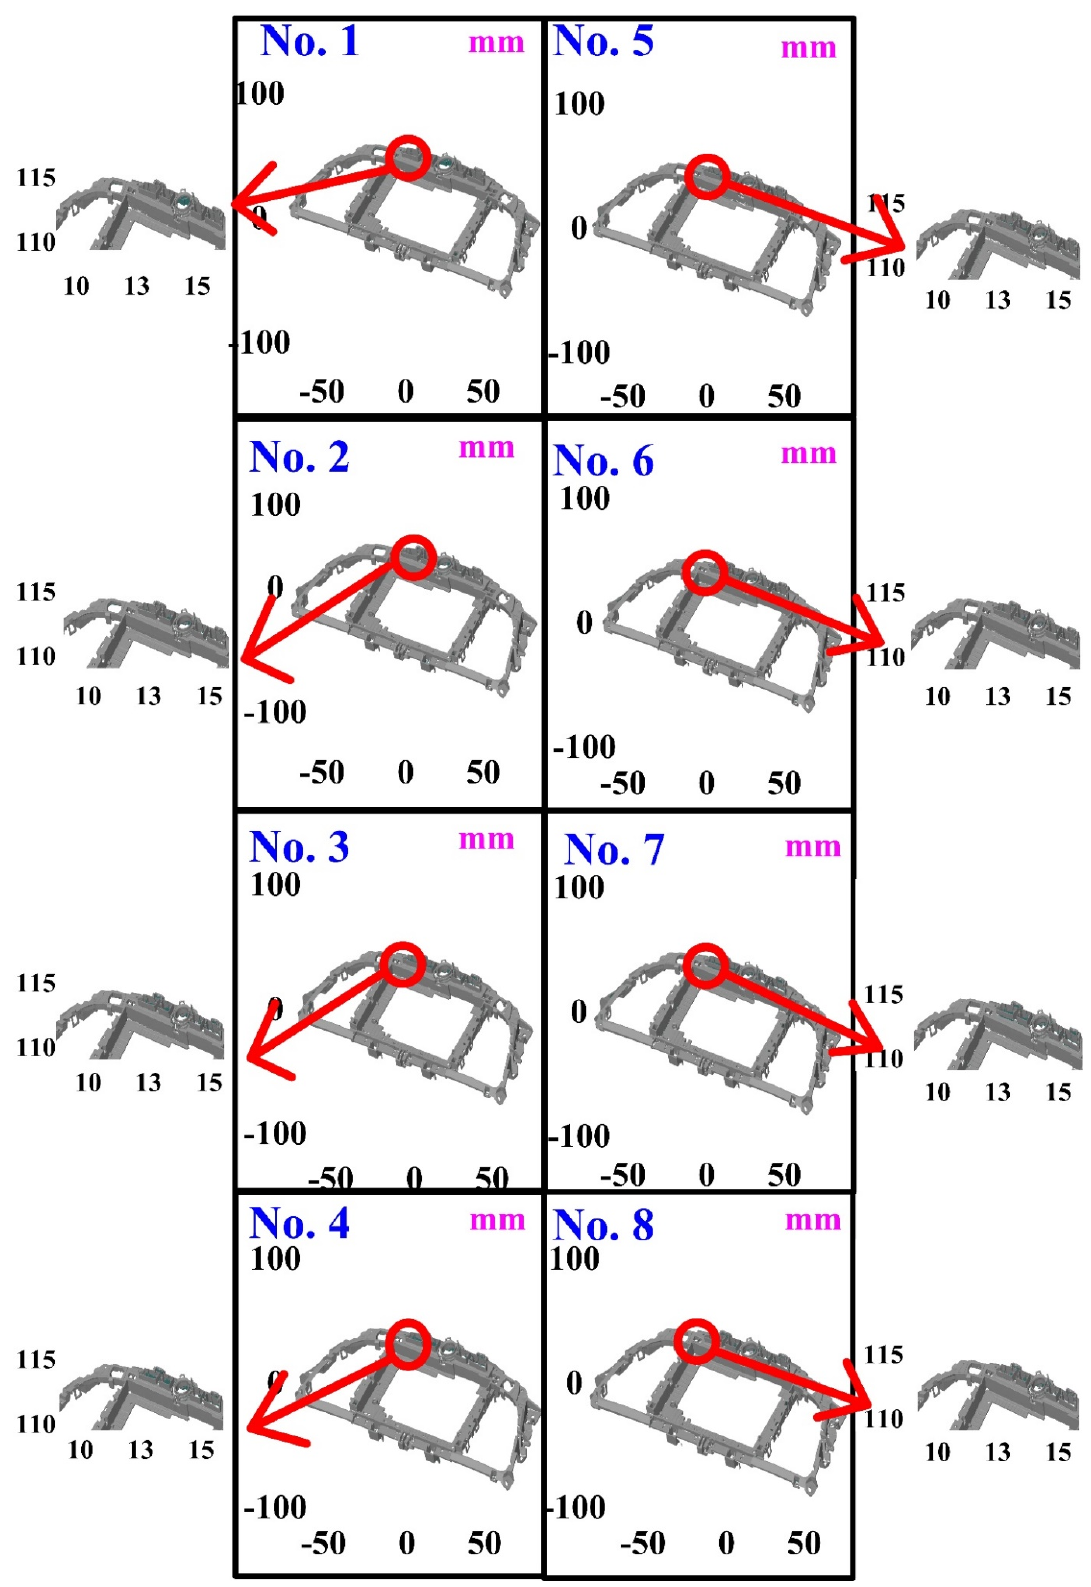
Figure 10. Measurement results of dark plastic part without sprayed mixture of TiO 2 powder and ethanol.